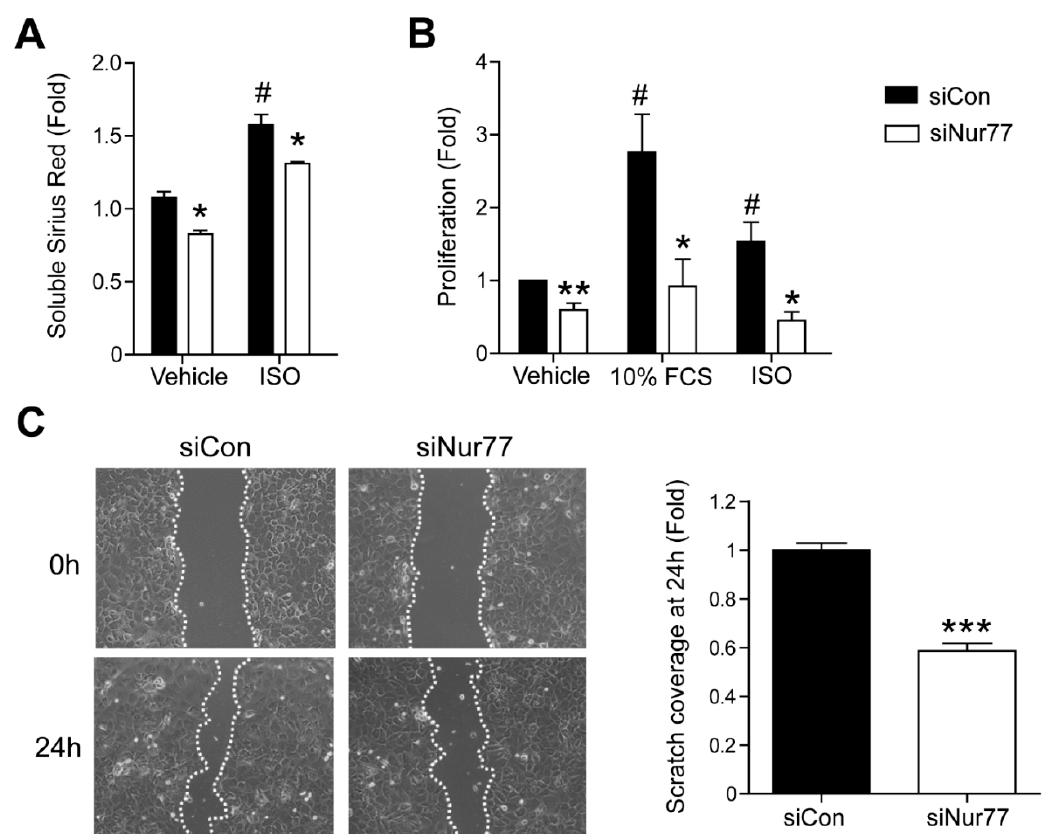
Figure 3. Nur77 knockdown in cardiac fibroblasts (CFs) represses MyoFB functional characteristics in CF. ( A ) CF collagen content as measured by soluble Sirius red assay. ( B ) CF proliferation as measured by bromodeoxyuridine (BrdU) incorporation. ( C ) CF wound closure capacity in scratch wound assay; quantification in the right panel. ( A ) ISO (10 μ M) stimulation was for 72 h. ( B ) ISO (10 μ M) stimulation was for 24 h. n = 3–4 independent experiments per group. Data presented as mean + SEM; # p < 0.05 vs. siCon vehicle; * p < 0.05, ** p < 0.01, *** p < 0.001 vs. siCon same stimulus.